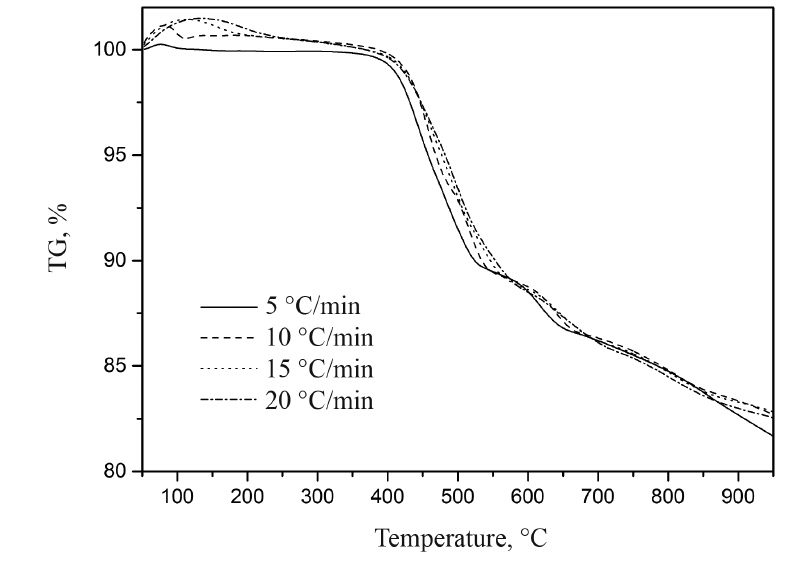
Fig. 1. TG curves of OS-Co samples at different heating